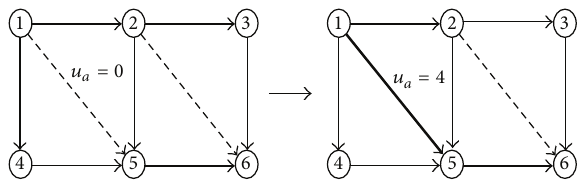
Figure 1: Neighboring function based on one link level being transformed.